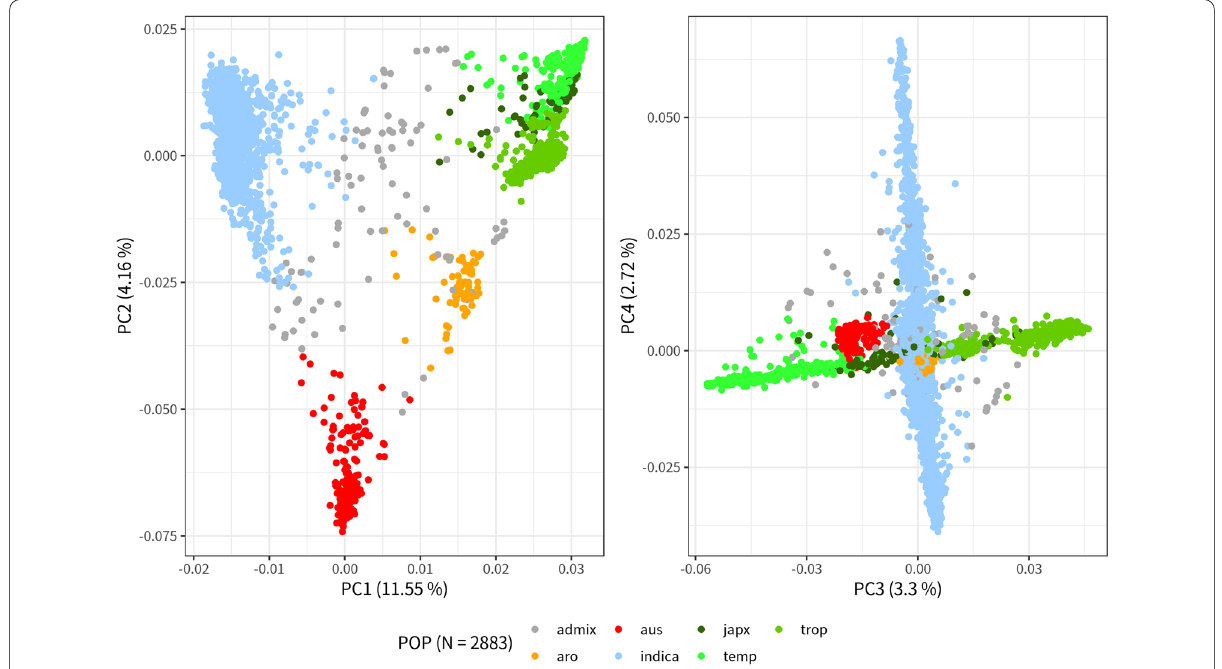
Fig. 2 PCA based on 2883 accessions 14,462 SNPs. Sub‑population designation of 2883 accessions was based on Wang et al. (2018): Admix: × admixed; aro: aromatic ; aus: aus ; indica: indica ; japx: admixed japonica ; temp: temperate japonica ; trop: tropical